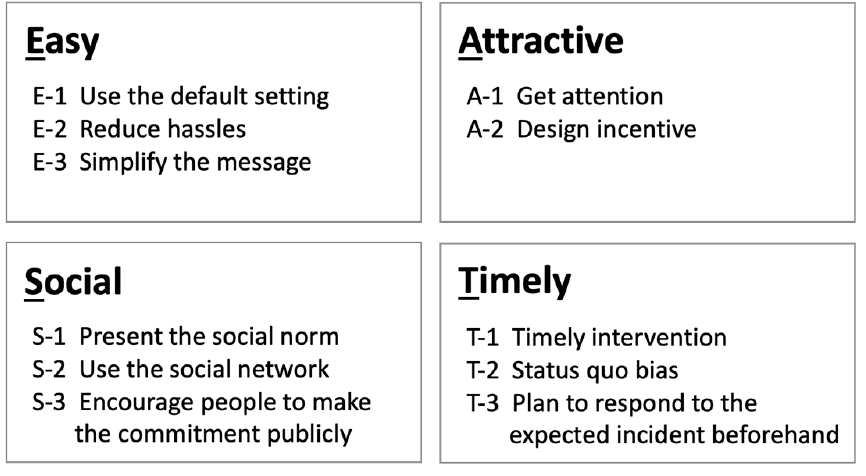
Figure 5. The EAST framework.